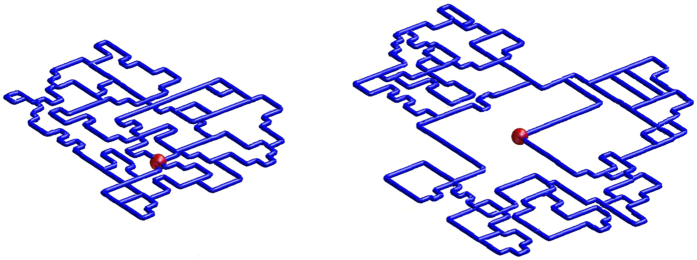
Artistic representation of ideal (left) and LIR (right) model configurations.The LIR model is forbidden from having self-intersections at the “origin”, and the configuration is drawn larger than its ideal partner to indicate its typically larger size.